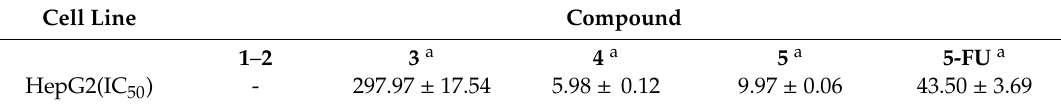
Table 2. Cytotoxicity data of compounds 1 – 5 .